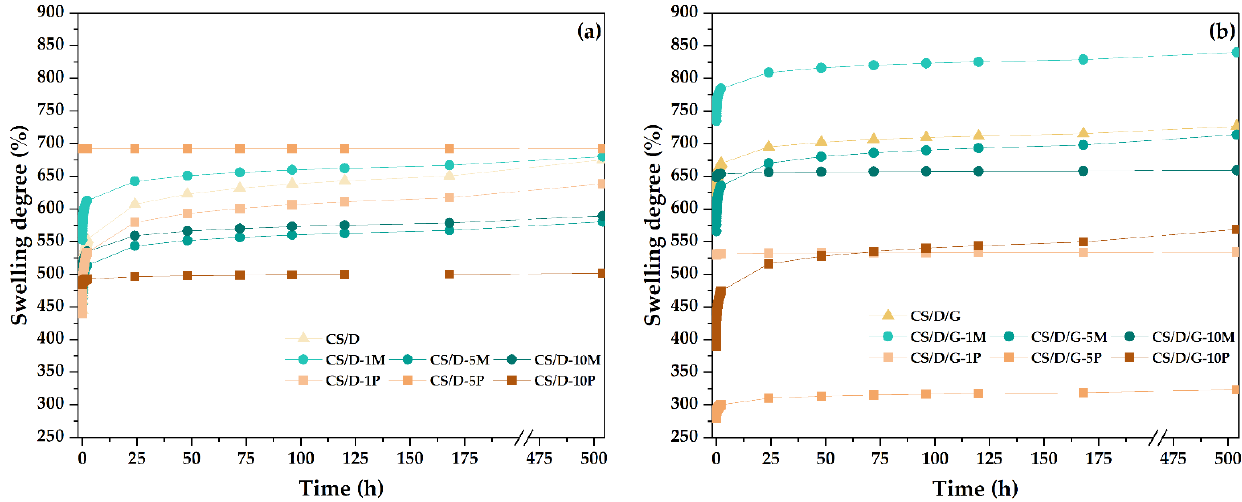
Figure 9. The evolution of swelling degrees of the CS/D ( a ) and CS/D/G hydrogels ( b ).